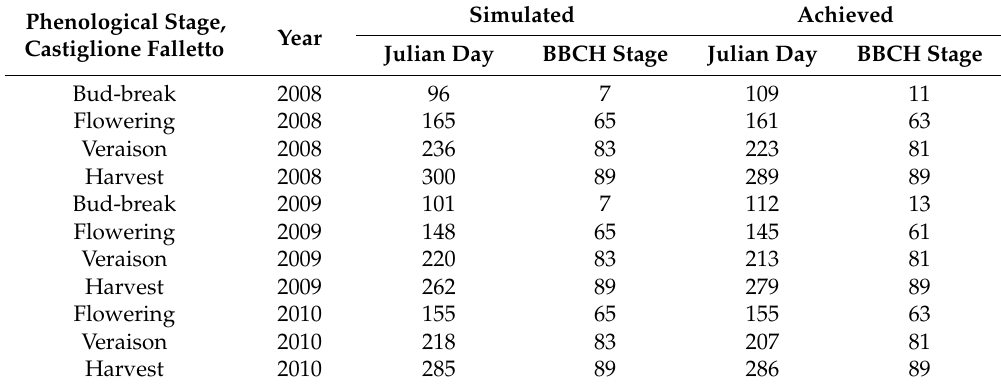
Table 2. Comparison between occurrence of simulated phenological stages (with their associated BBCH stages) and BBCH achieved stages in the Castiglione Falletto site.